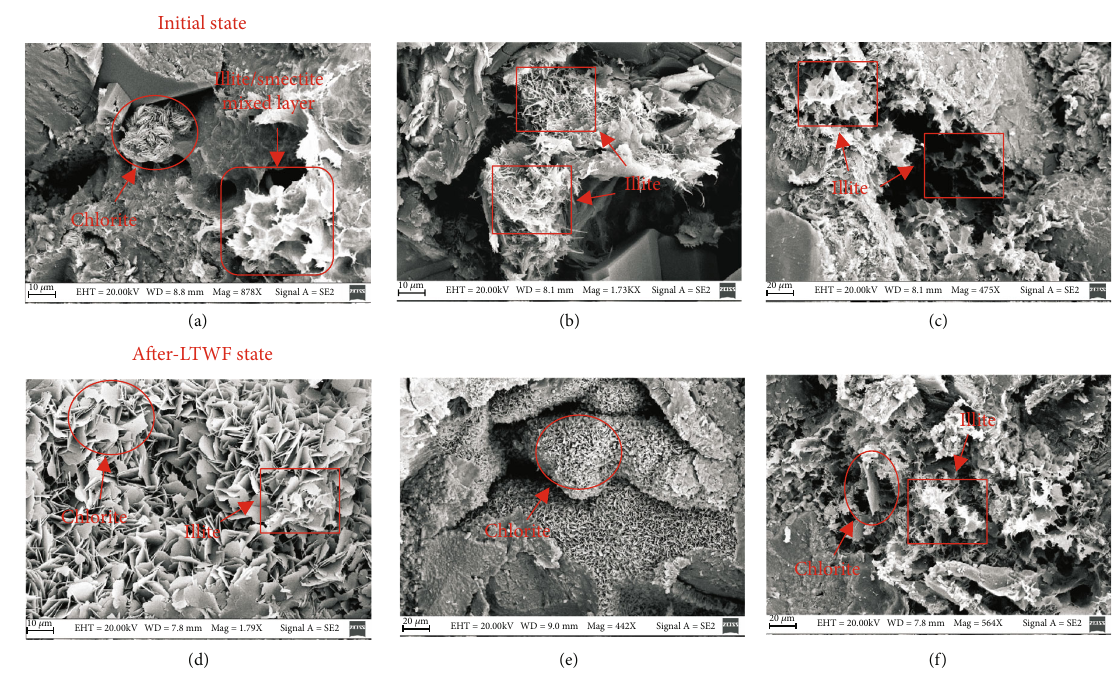
Figure 9: The SEM images at the initial state and after-LTWF